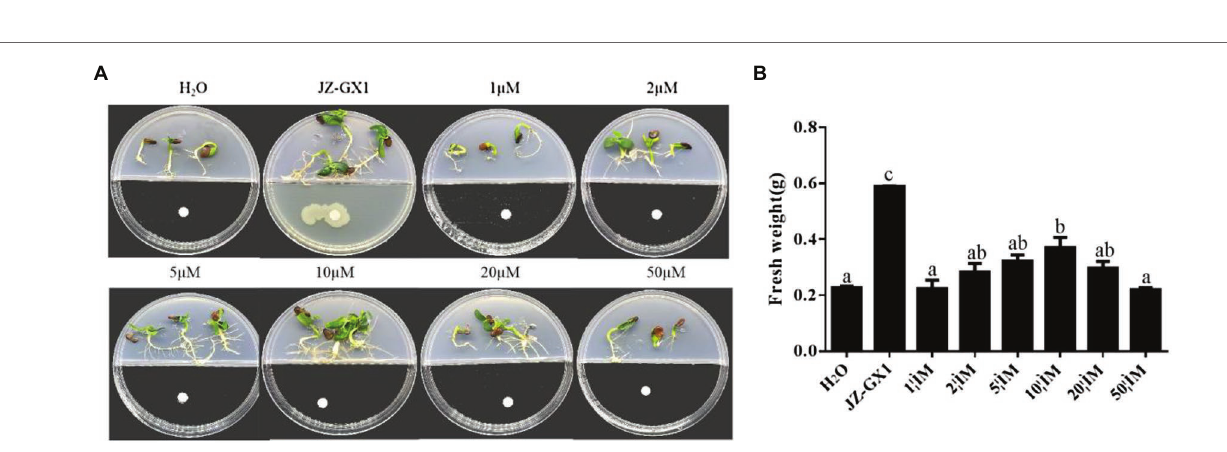
FIGURE 11 | Effect of different concentrations of 2,3-butanediol on R. pseudoacacia under salt stress conditions. (A) Phenotype; (B) fresh